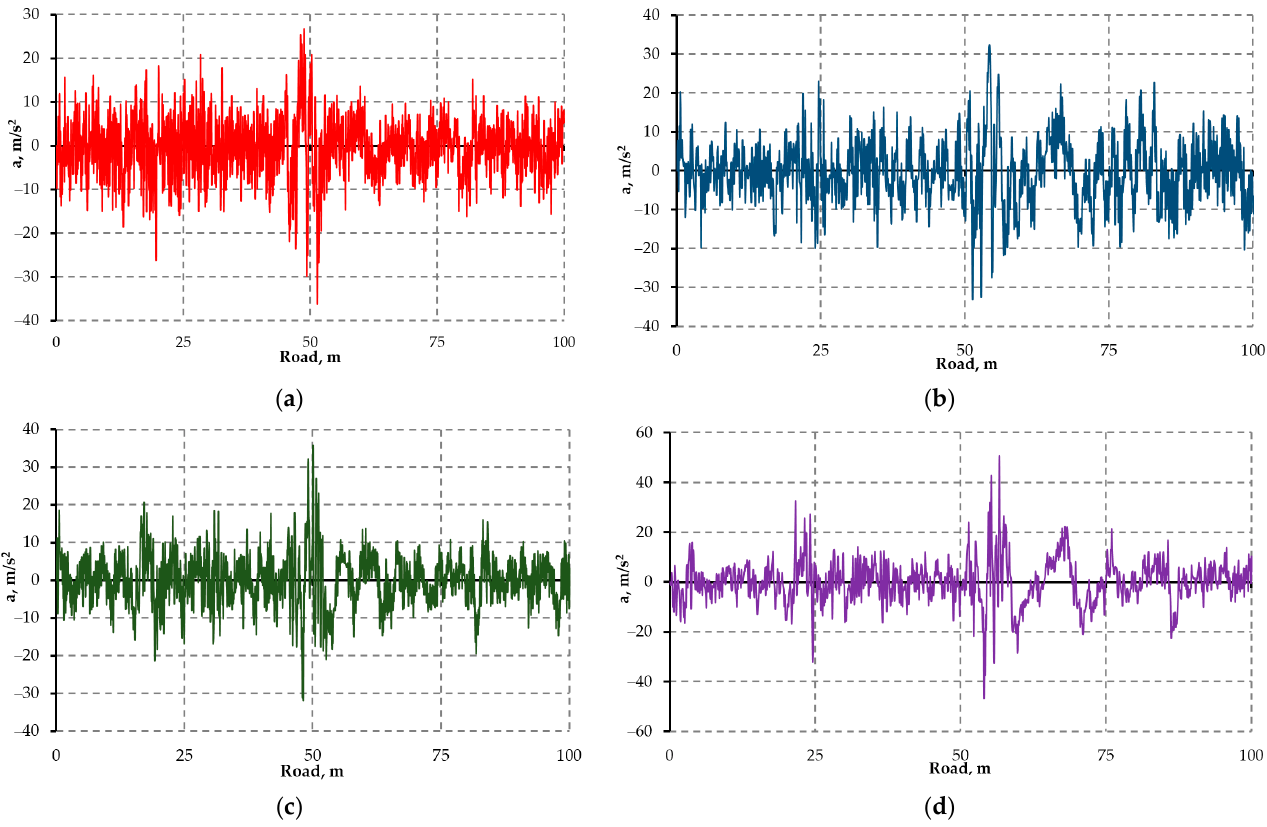
Figure 26. Accelerations of the unsprung masses of compact car measured on a city-type road at different speeds: ( a , b )— front; ( c , d )—rear; ( a , c )—50 km/h; and ( b , d )—70 km/h.